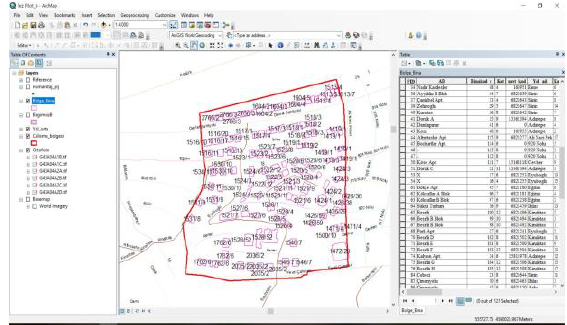
Figure 3. Creating a database in a GIS environment